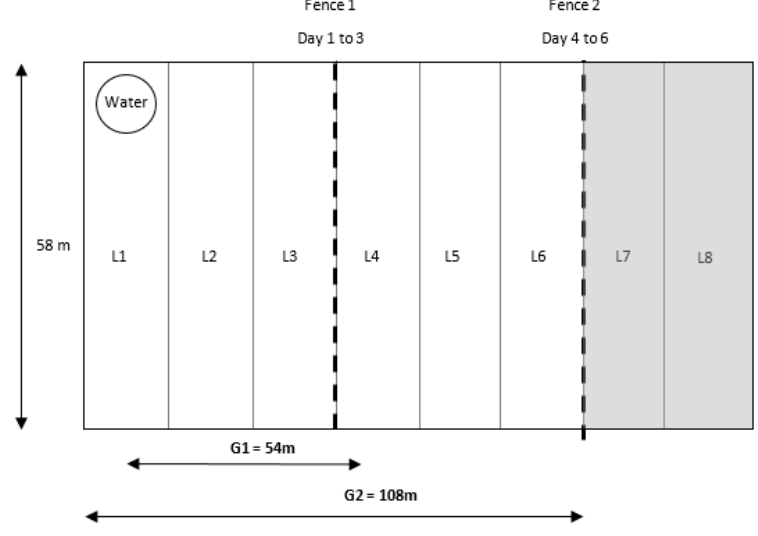
Figure 1. The training paddock used to evaluate learning of the virtual fence stimuli and spatial usage of the paddock. The position of the water trough is indicated. The paddock was divided into 8 equal locations (L1 to L8 as indicated) using GPS co-ordinates, as indicated by the dashed lines. On days 1 to 3, cows were offered L1 to L3 (grazing allocation 1, G1), and on days 4 to 6, cows were offered L1 to L6 (grazing allocation 2, G2). A third section of pasture (grey shaded area) remained unallocated as the exclusion zone. A virtual fence was set at L3 / L4 for G1 and L5 / L6 for G2, as indicated by the dashed